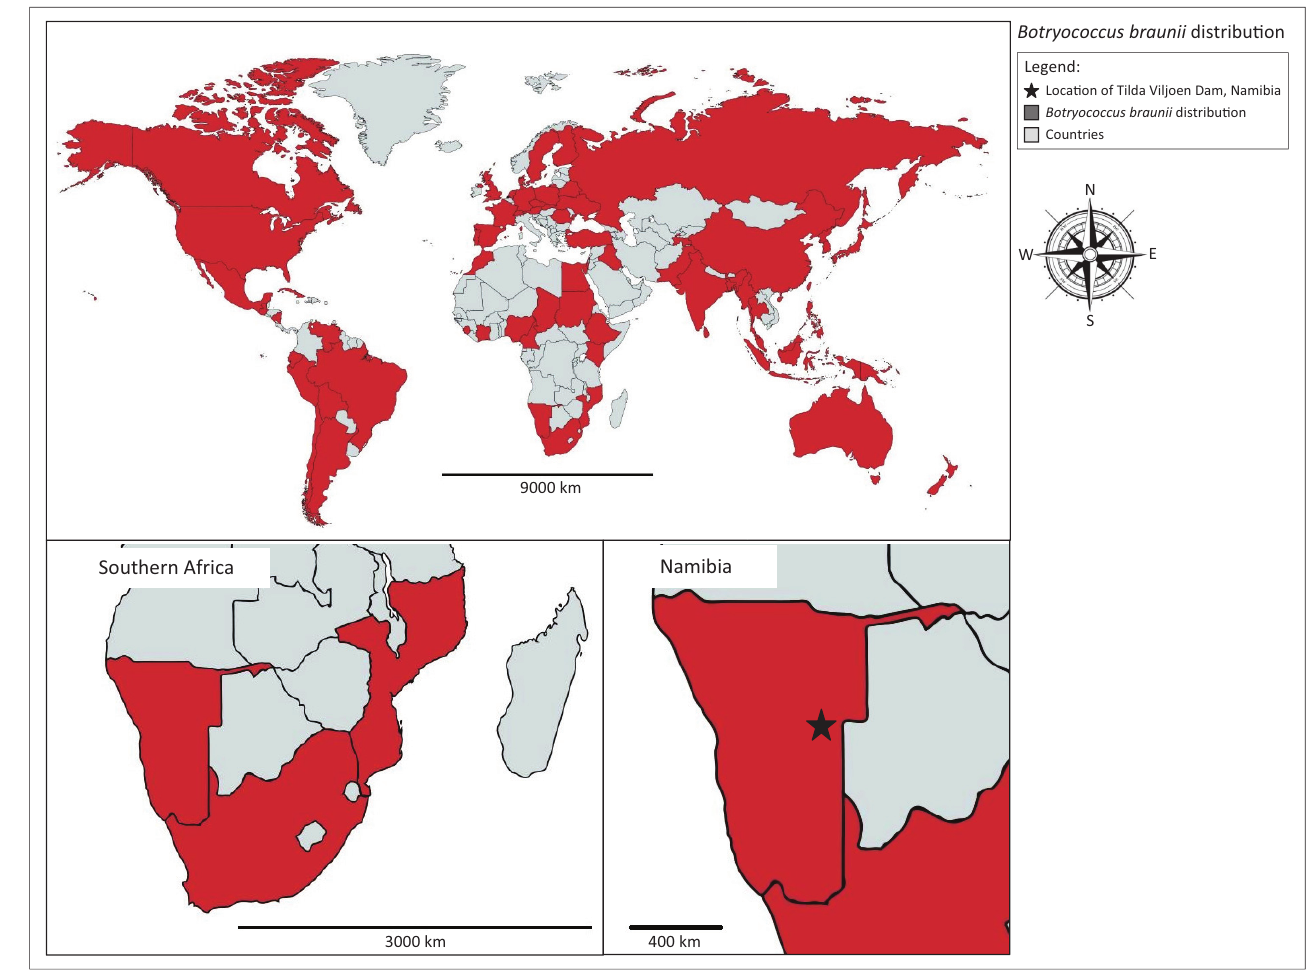
FIGURE 1: Current known distribution of Botryococcus braunii . Map created with mapchart.net.